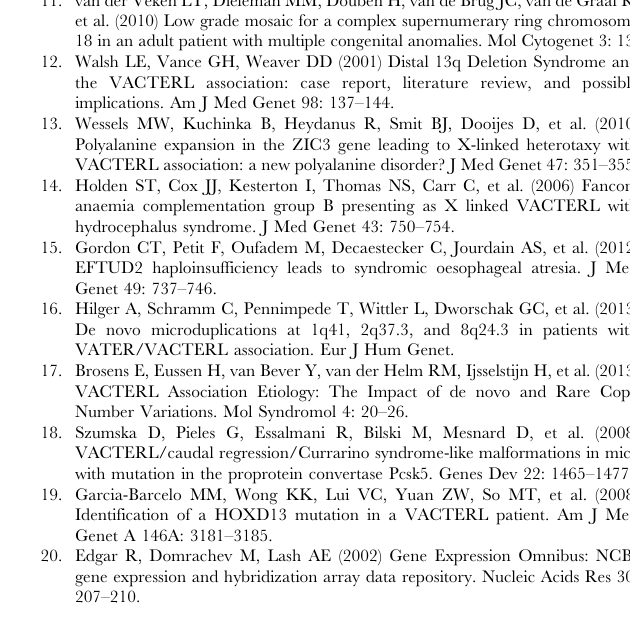
Table S4 Copy number variants of unclear